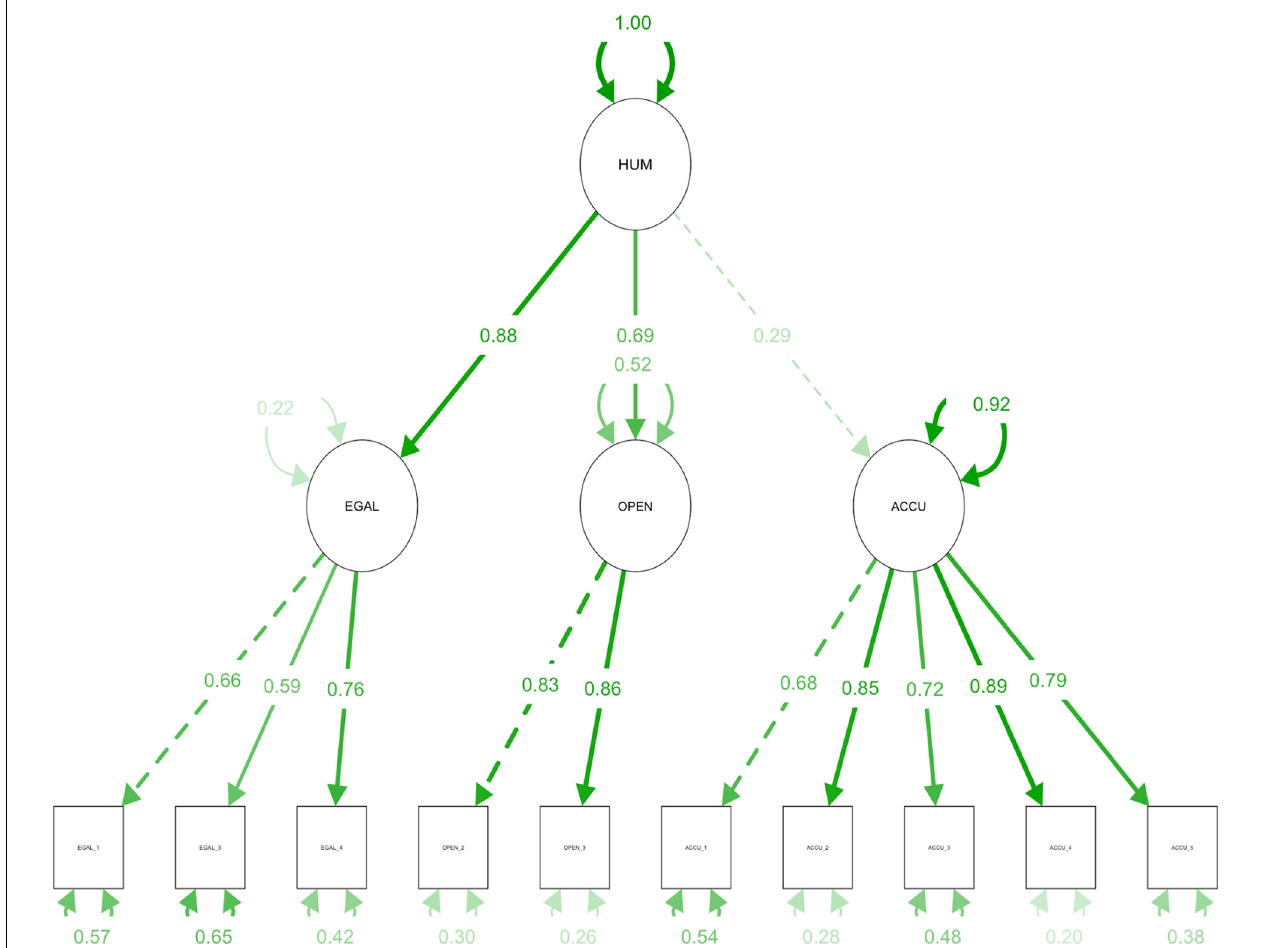
FIGURE 1 | Factor structure of humility as a latent construct. HUM = Humility; EGAL = Egalitarianism; OPEN = Open-mindedness; ACCU = Accuracy. χ 2 (32, N = 269) = 76.07, p < 0.001, CFI = 0.964, RMSEA = 0.072, RMSEA CI 90% = [0.051,0.092], SRMR = 0.046.